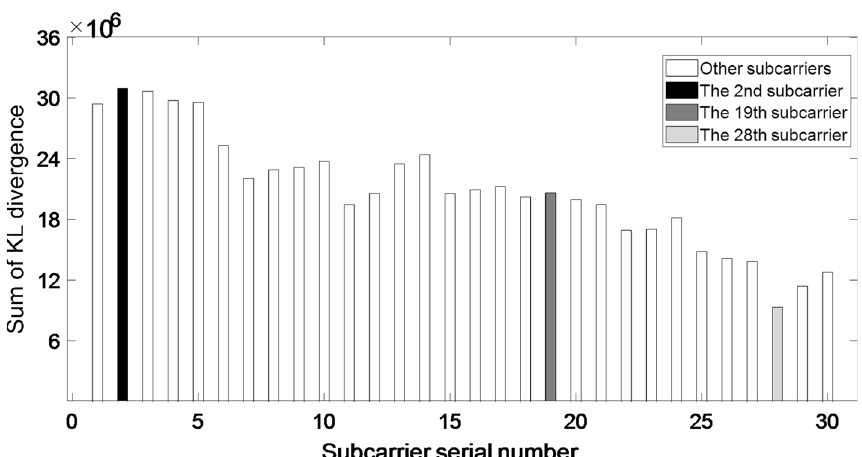
Fig. 10 Sum of KL divergence of 30